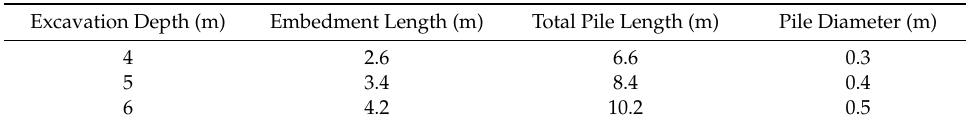
Table 4. The design dimensions of cantilever soldier pile walls based on the excavation depth ( q = 0 kPa loading condition).